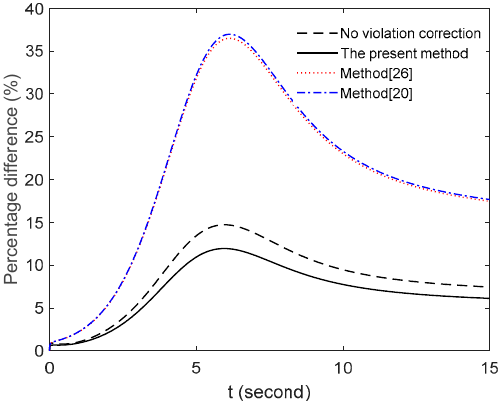
Figure 10. Percentage difference of four methods with h = 0.01 comparing to the numerical method [26] with h = 0.0001.